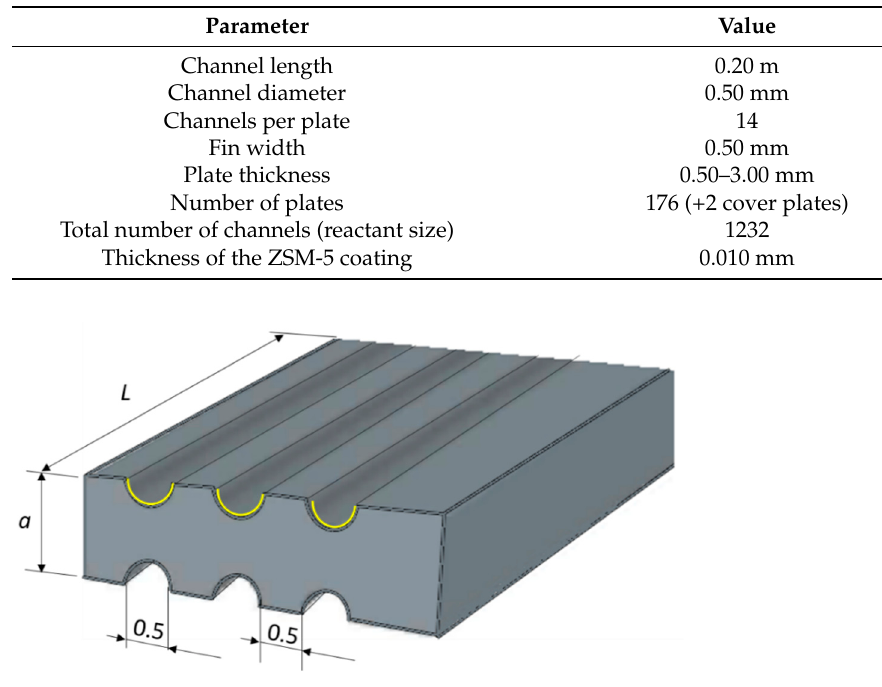
Figure 2. Schematic view of a periodic unit of the microchannel reactor/heat exchanger showing 3 out of 14 parallel semicylindrical microchannels. The yellow color represents the H-ZSM-5 coating in the reaction channels.